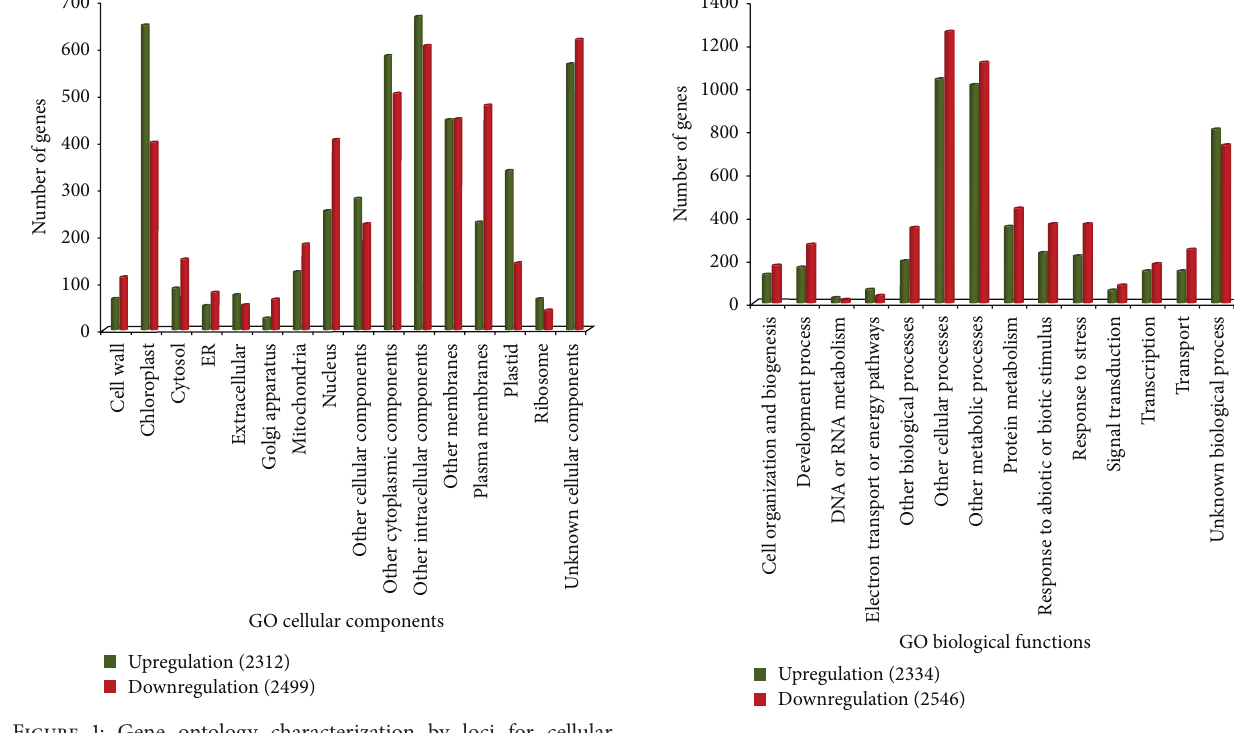
Figure 1: Gene ontology characterization by loci for cellular components. Figure 2: Gene ontology characterization by loci for biological functions.